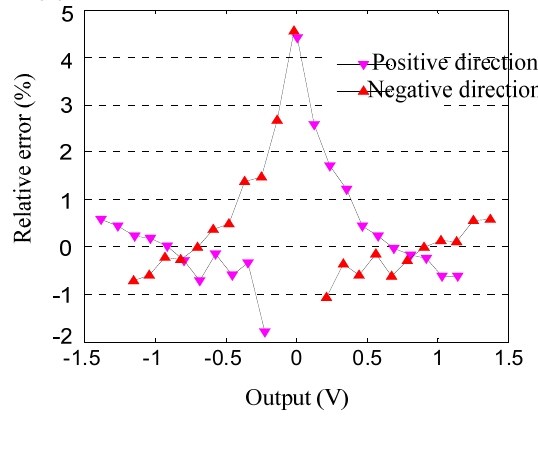
Figure 7. Relative error of